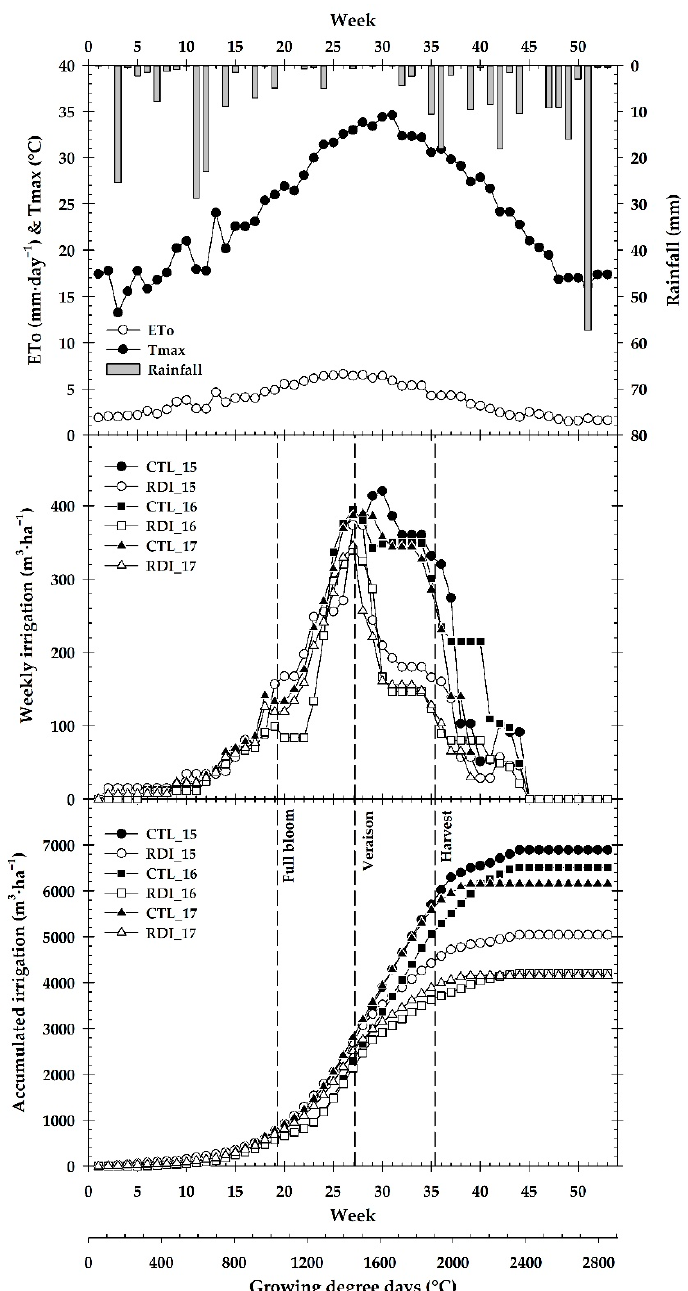
Figure 8. Average seasonal evolution of reference crop evapotranspiration (ET 0 ), vapor pressure deficit (VPD), temperature and rainfall during the three years assayed (2015–2017). Seasonal variation of irrigation water applied weekly and cumulative water applied, for CTL and RDI treatments: CTL (black circles, 2015; black squares, 2016; black triangles, 2017) and RDI (white circles, 2015; white squares, 2016; white triangles, 2017). The dashed lines indicate the full bloom, veraison and the harvest periods.